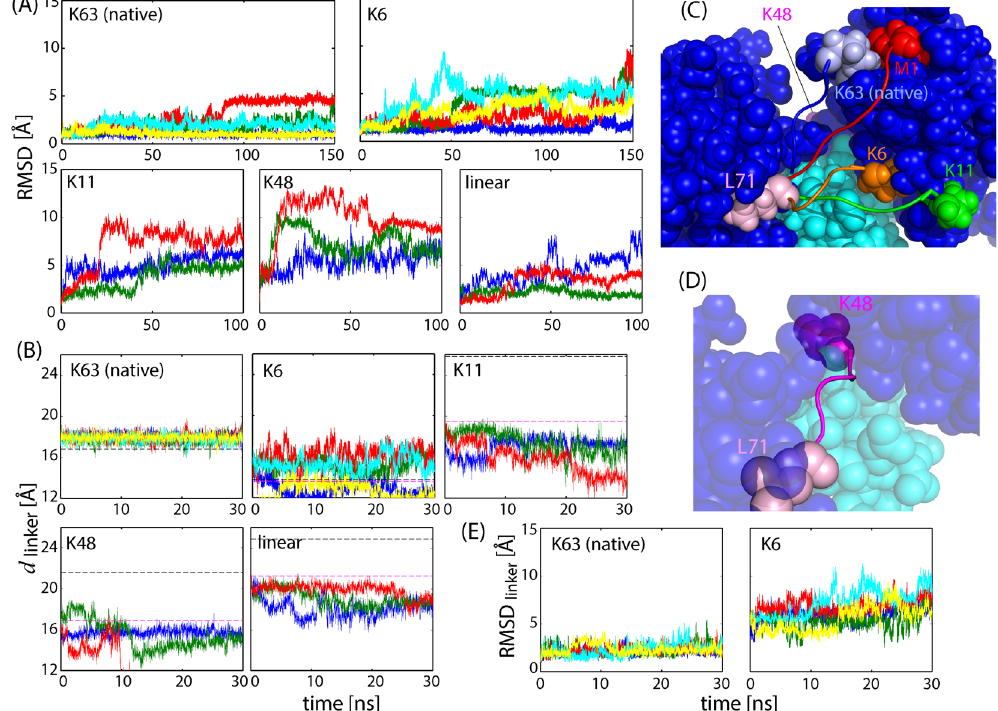
Figure 7. MD simulations of native K63-diUb/TAB2 NZF complex and artificially linked K6, K11, K48 di-UB/ TAB2 NZF complexes. ( A ) C α RMSD during the simulations of the five di-Ub/TAB2 NZF complexes (native K63: 5 × 150 ns; K6: 5 × 150 ns; K11, K48 and linear: 3 × 100 ns) from each initial model after superimposing C α atoms of di-Ub (1–70). Note that the initial model for K63 is the crystal structure (PDB: 2wwz), but that the other models are different from each other depending on the modeling procedures (see Methods for details). ( B ) The linker length, d linker , or distance between C α of L71 and N ζ of each Lys residues (either K63, K6, K11, or K48 di-Ub) or N of M1 for linear di-Ub. The first 30 ns data are shown here. The horizontal black and pink lines are the d linker values for the crystal structure and for the initial models, respectively; these values are different from each other depending on the linkage. ( C ) The initial models for MD simulations: di-Ub: blue; TAB2 NZF: cyan; linkers (71–76) and lysine residues (or M1): light blue (K63), red (linear), orange (K6), and green (K11). The linker of K48 (pink) is not drawn here because it is located on the other side of the proximal Ub. ( D ) The initial model for the K48 complex. ( E ) C α RMSD of the Ub-Ub linker (71–76) for K63 and K6 di-Ub/TAB2